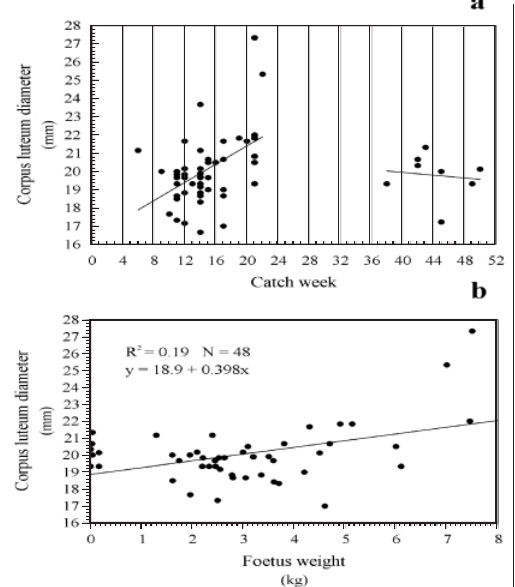
Fig. 6 . Relationship between Corpus luteum diameters and catch week (a) and foetus weight (b). Linear regression lines are